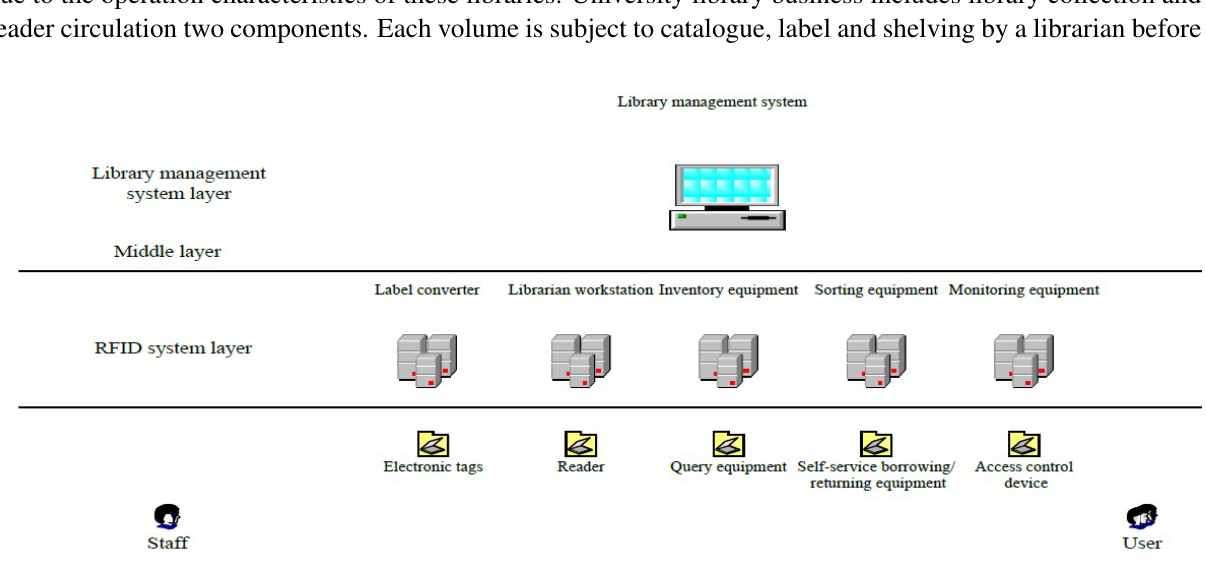
Fig. 1 RFID system. RFID, radio frequency